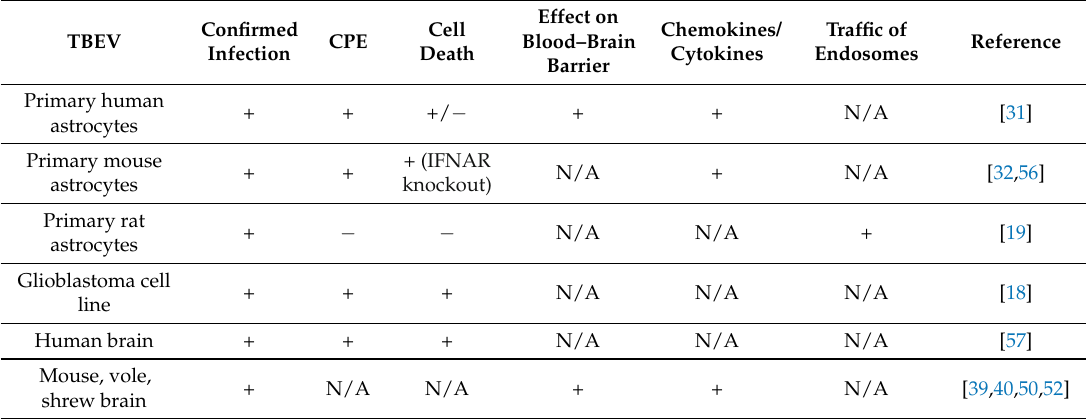
Table 1. Confirmed effects of tick-borne encephalitis virus (TBEV) infection on astrocytes and whole